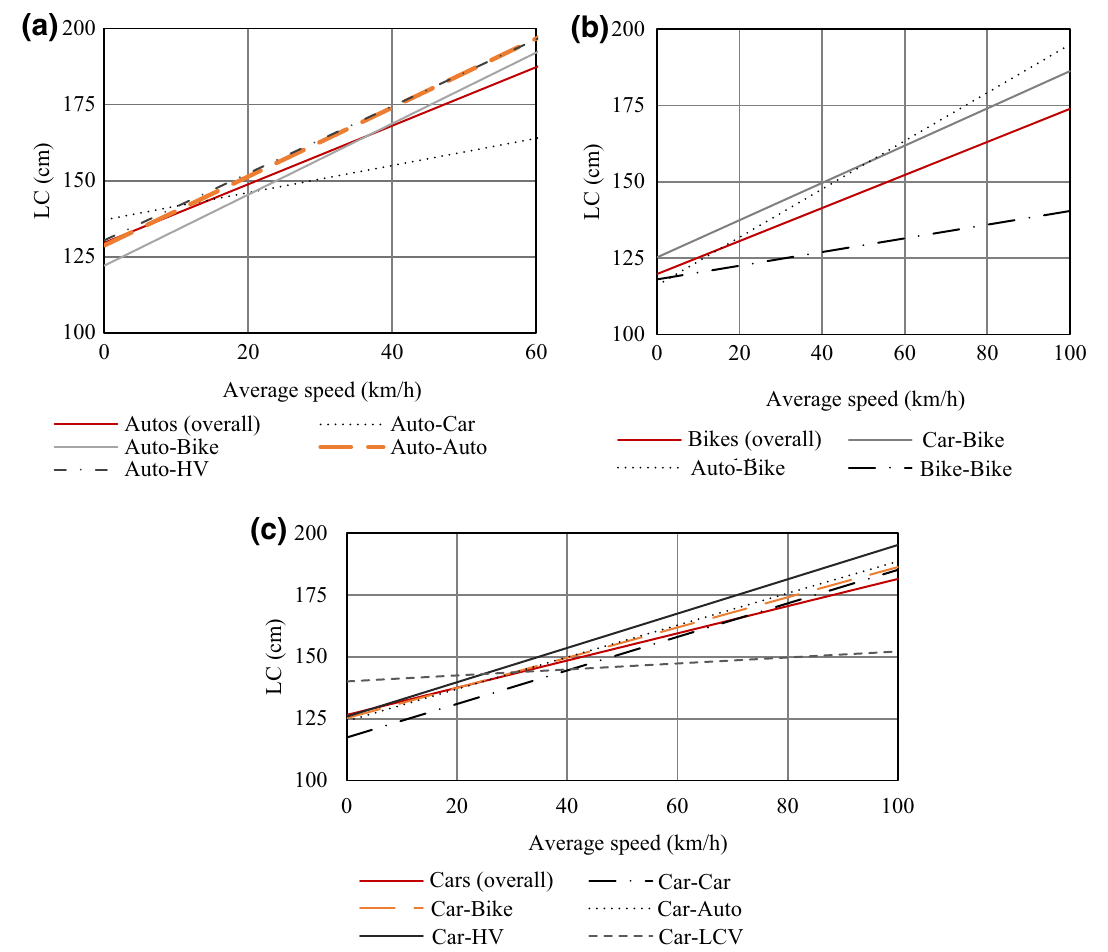
Fig. 8 Comparison of vehicle pair behavior with overall behavior of autos (motorized three-wheelers) ( a ), bikes (motorized two-wheelers) ( b ) and cars ( c )